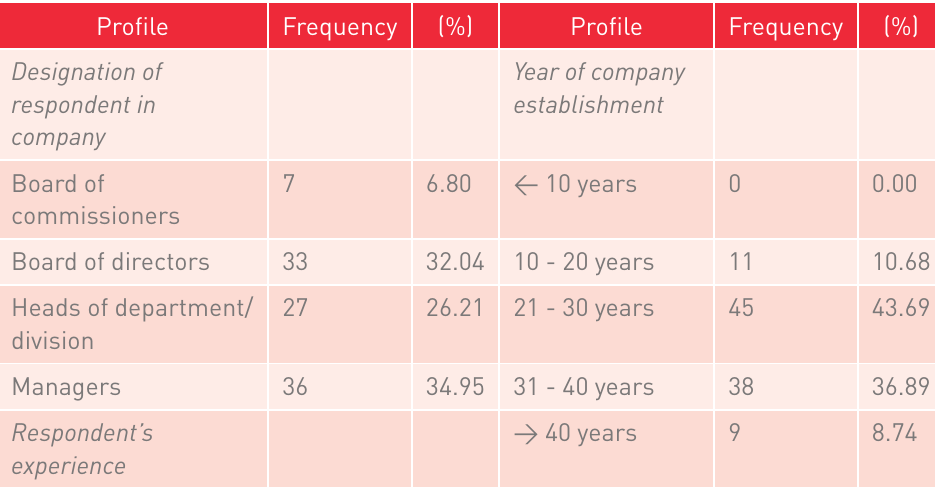
Profile of respondent and participating